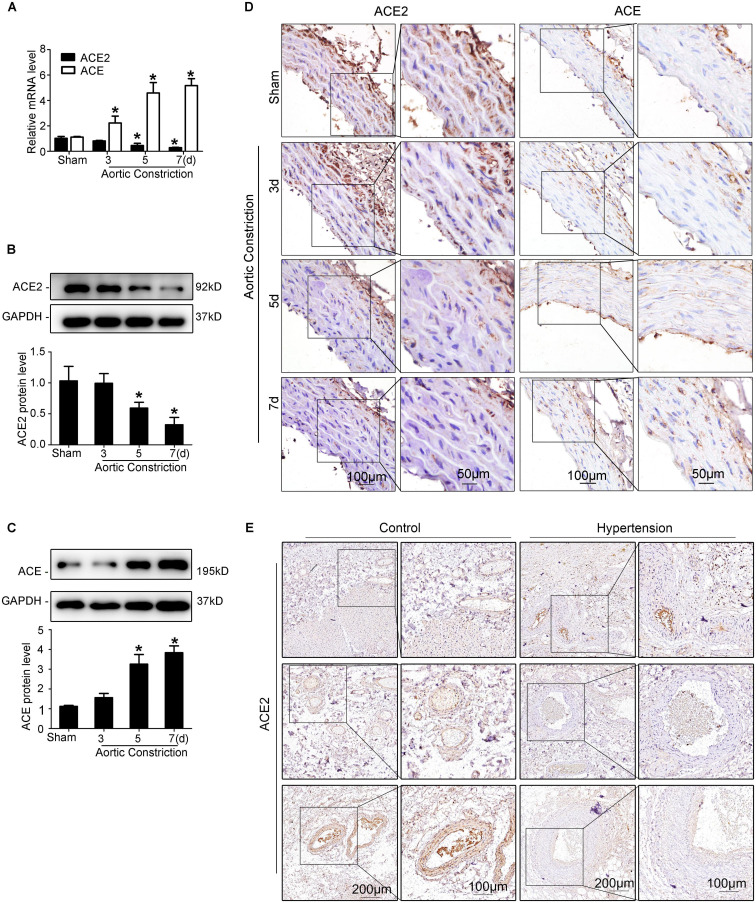
Elevated mechanical stretch suppresses ACE2 and increases ACE expression in the aorta in vivo. (A) ACE2 and ACE mRNA expression in the aortas of the aortic constriction group and the sham group by RT-qPCR. (B,C) ACE2 and ACE protein levels in the aortas of the aortic constriction group and the sham group by Western blot. (D) Representative immunohistochemical staining of ACE2 and ACE in sections from the aortas of the aortic constriction group and the sham operation group. (E) Representative photomicrographs of immunohistochemical staining of ACE2 in the paracancerous tissues of patients with hypertension or without. Values are expressed as means ± SEM. *P < 0.05 vs. sham (n = 4).